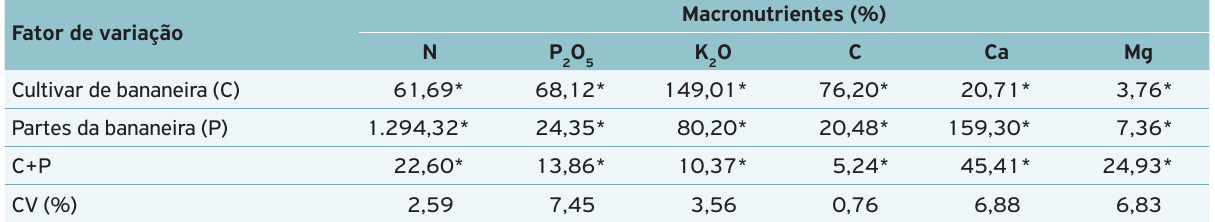
Tabela 4. Valores F obtidos na análise de variância de macronutrientes nos subtratos residuais à base de resíduos